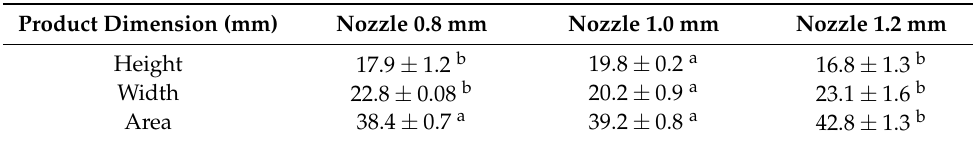
Figure 18. The 3D-printed rice paste with various nozzle diameters (0.8, 1.0, and 1.2 mm) before and after steaming. Table 7. Image analysis of the printed rice paste